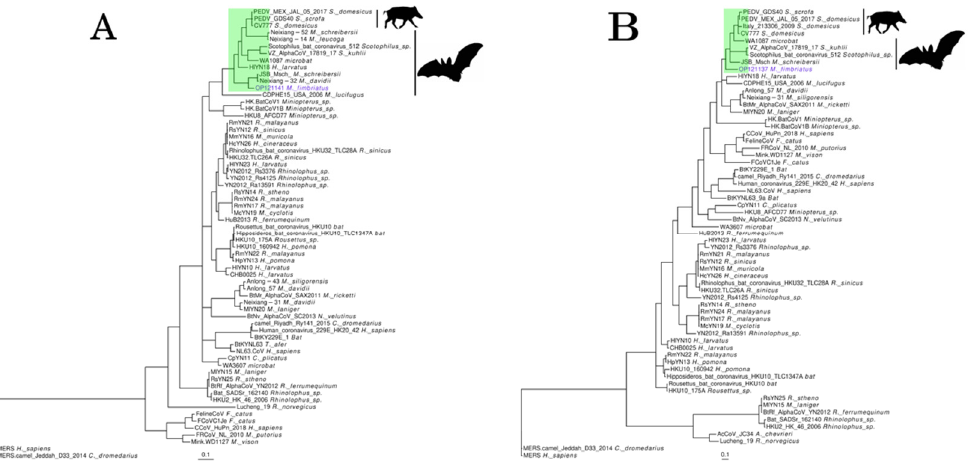
Figure 2. Pedacovirus. Phylogenetic trees of representative alphacoronavirus sequences were ob- tained for ( A ) a 291 a.a region of the ORF1b protein and ( B ) a 141 a.a region of the spike. The trees were inferred under a general matrix model (LG), with gamma-distributed rate variation among sites (G) and the proportion of invariable sites (I). Pedacovirus subgenus is highlighted in green.